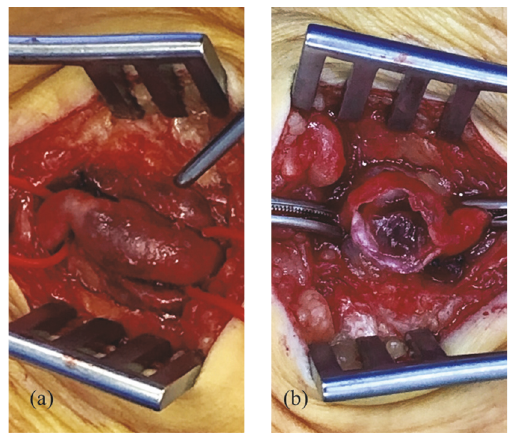
Figure 3: Intraoperative images demonstrating exposure of the posterior tibial artery aneurysm (a) and containing intramural thrombus (b).